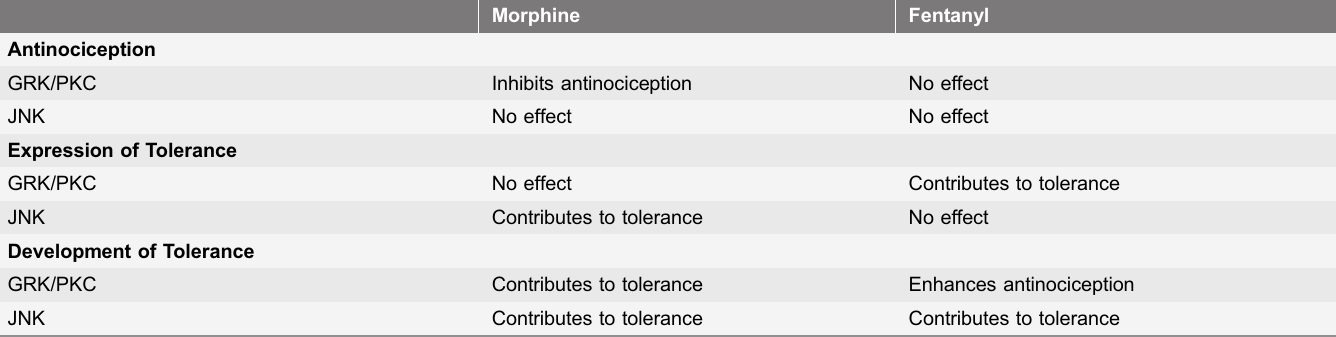
Table 3. Summary of ligand-biased signaling for morphine and fentanyl antinociception and tolerance following microinjection into the ventrolateral